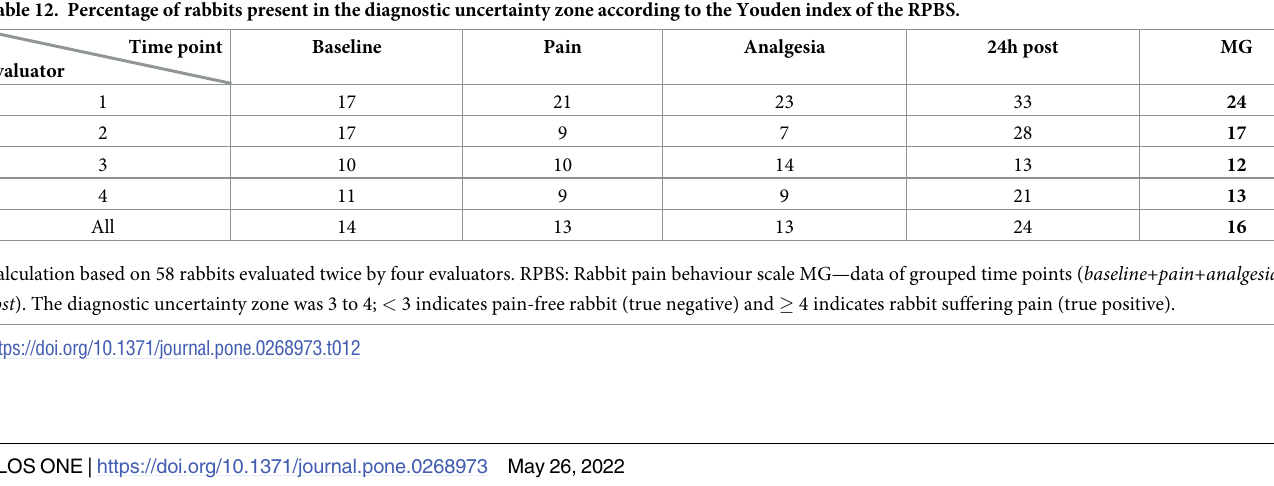
validated scales in other species [15, 22–25]. According to PCA all items pertained to the first dimension, except attention to the affected area, which pertained to the second dimension. Due to the PCA indicating that the RPBS is potentially bidimensional, data were further pro- cessed for confirmatory factor analysis (data not shown), Horn’s Parallel Analysis, March- enko-Pastur limit and Gavish-Donoho method to compare a one-dimensional model against a two-dimensional model. To proceed confirmatory factor analysis, it is recommended to include, in the structural models, more than three variables in each dimension to avoid calcu- lation error. Except for the Horn’s Parallel Analysis which suggested two dimensions, March- enko-Pastur limit, Gavish-Donoho method and confirmatory factor analysis showed no improvement by using a two-dimensional model, which supports the conclusion that the one- dimension model offers the best fit for RPBS. RPBS is mathematically unidimensional, but biologically multidimensional, as it assesses other dimensions in addition to pain intensity [65], such as temporal (score changes after sur- gery and after rescue analgesia) and qualitative characteristics of pain: sensory (attention to the affected area and miscellaneous behaviour), affective (interaction with motivational items, exploration), cognitive (posture and activity) and physiological (appetite) dimensions. The different scores (0, 1, or 2) assigned to each item on the scale were distributed as expected. Scores "0" predominated at baseline for all scale items and scores 1 and 2 predomi- nated after surgery, that is, at the time of greatest expected pain. At 24h post , the scores were similar to the baseline time point, except for the item “attention to the affected area”, which presented increased scores after surgery, but did not return to baseline values after 24 hours, possibly due to the residual nociceptive stimulus produced by local inflammation. Concurrent and predictive criterion validity are crucial attributes in the validation of a new instrument [23–25]. The concurrent criterion validity assesses whether the new instrument is comparable to an established method with the same aim [63, 66]. For this purpose, the RPBS was compared to the unidimensional scales VAS, SDS, and NS, as described for other species [15, 22–24], and to the facial scale (RbtGS) [18], the only instrument available to assess pain in Table 12. Percentage of rabbits present in the diagnostic uncertainty zone according to the Youden index of the RPBS. Time point Evaluator